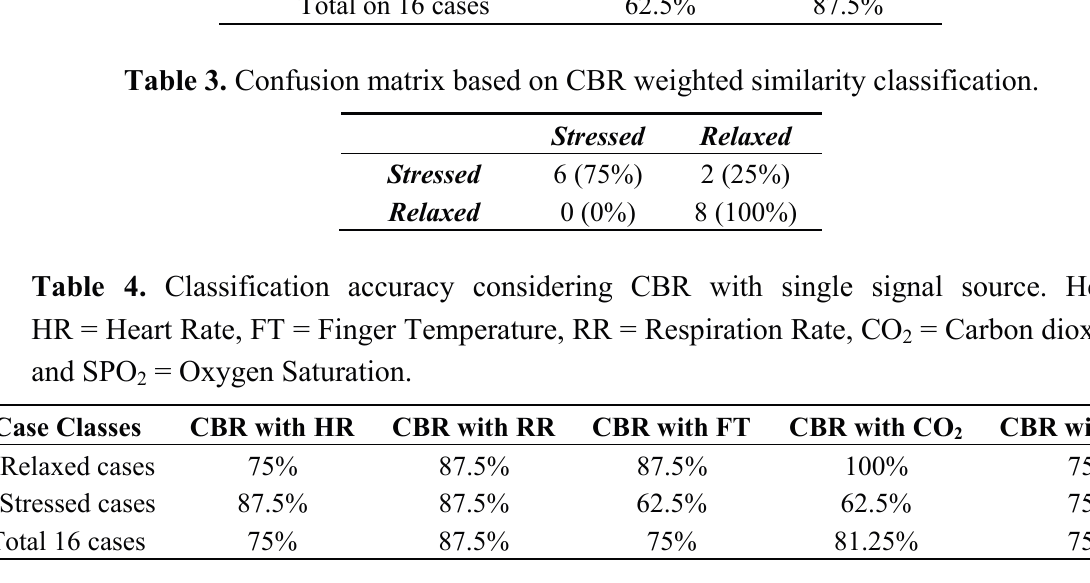
Table 3. Confusion matrix based on CBR weighted similarity classification.